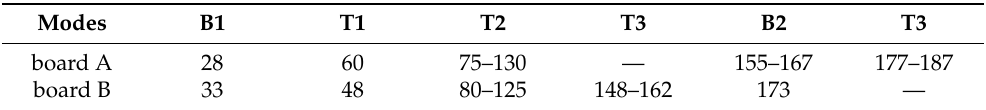
Table 1. Vibration modes of the shovel and their associated frequencies in Hertz; B = bending; T =